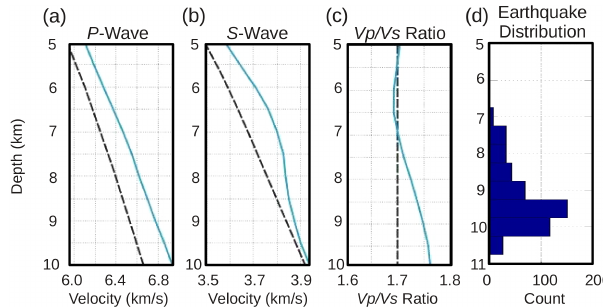
Figure 6. Average P -wave velocities (a) , S -wave velocities (b) , and Vp / Vs ratio values (c) within the focal zone. The average WAM values (solid lines) are calculated for all resolved nodes within ± 4km from the grid origin and in 0.5km thick layers. The distri- bution of earthquake source in depth (d) is also shown. Please note the different depth scale in (d) . Dashed lines indicate the regional model from Málek et al.